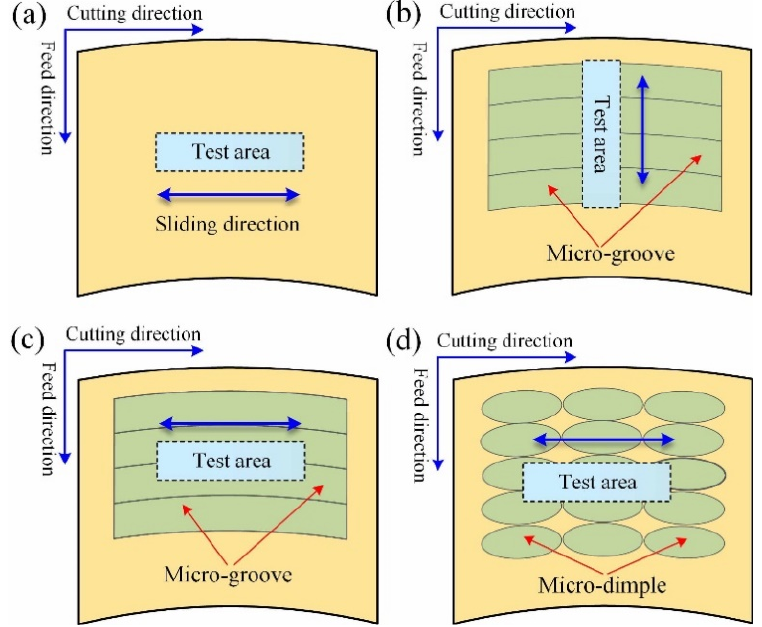
Figure 9. Test scheme for different surfaces: ( a ) surface #6; ( b ) surface #5; ( c ) surface #5; ( d ) surface #1.